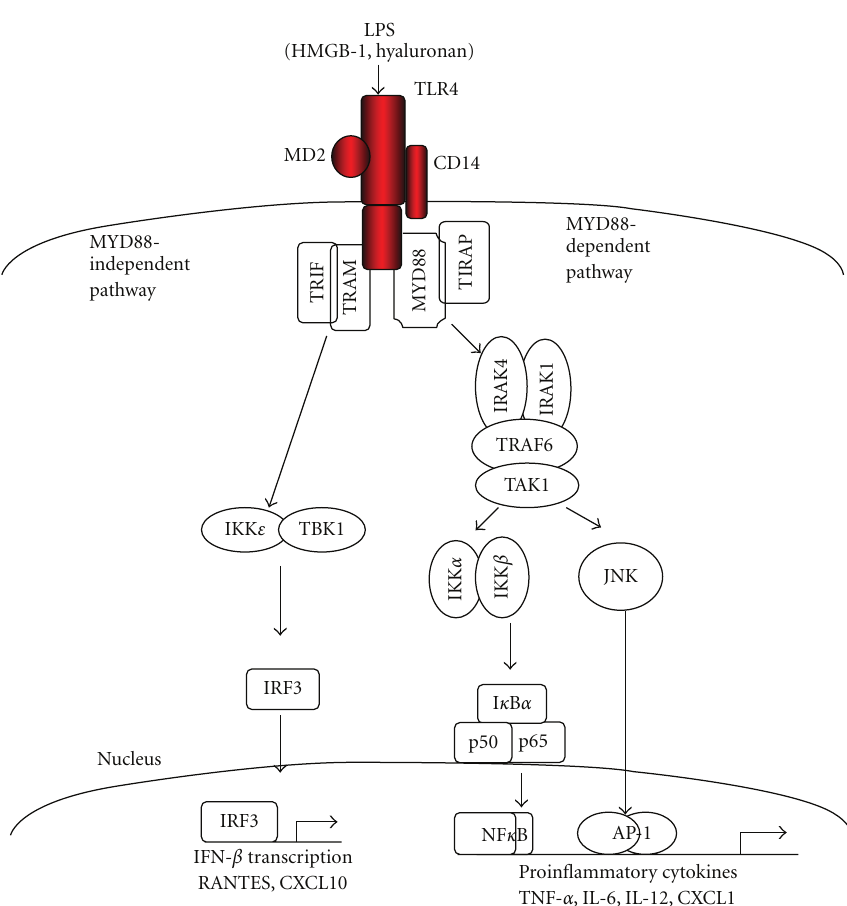
Figure 3: Schematic overview of TLR4 signaling pathways. LPS and other ligands bind TLR4, which transmit the signals through MyD88 to the activation of NF κ B and p38/c-Jun N-terminal kinase (JNK). TIRAP bridges TLR4 with MyD88. TRAF is utilized by TLR4/TRAM to activate TBK1/inhibitor of NF κ B kinase (IKK) (cid:2) leading to IRF-3 activation followed by IFN- β